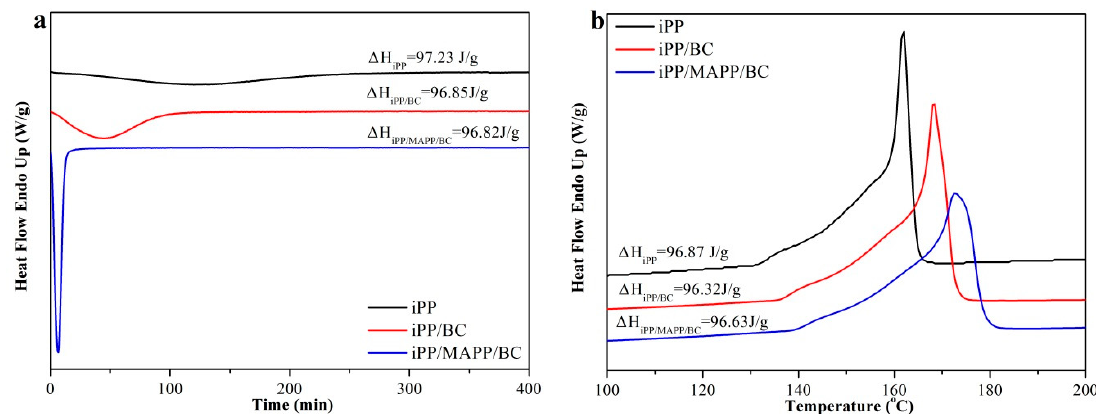
Figure 2. POM photograph showing transcrystallization of iPP/BC hamburger composite at 138 °C ( a , b , c: iPP/BC; d , e , f: iPP/MAPP/BC).